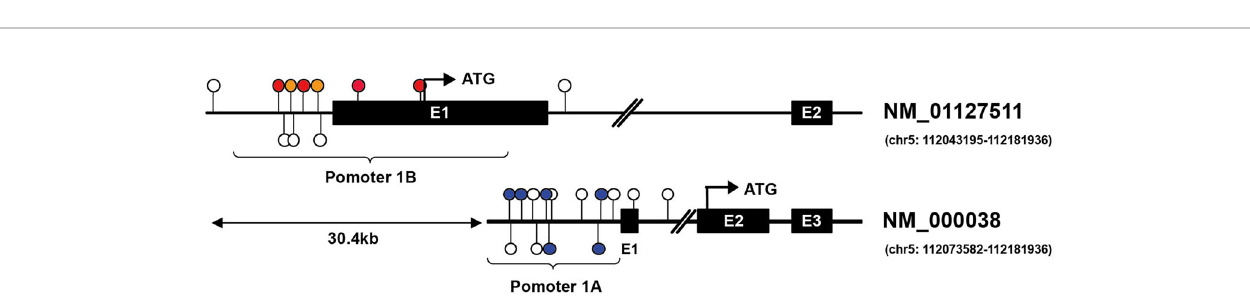
FIGURE 2 | Illustration of CG locus in APC promoters in gastric and hepatic cancers. Promoter 1A (chr5: 112072720 – 112073585, GRCh37/hg19) is located at approximately 30.4 kb in the downstream region of promoter 1B (chr5: 112043008 – 112043594, GRCh37/hg19) of the APC gene. The colored lollipops denote statistically signi fi cant hypermethylated CG loci associated with prognosis, while the blue color indicates good prognosis, and the orange color means poor prognosis in gastric cancer; the red indicates poor prognosis in hepatic cancer [the colored lollipops referring to CG locus from left to right are cg04011030, cg18315896, cg08934600, cg18536802, cg08512345, cg25922032 (promoter 1B); cg00577935, cg14511739, cg14479889, cg16970232, cg23938220, cg02511809 (promoter 1A)]. Illustrator of biological sequences (IBS) was used to create the